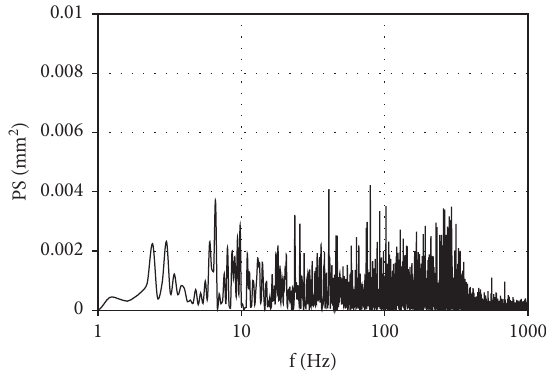
Figure 10: Power spectrum of shock oscillations for microstep at X / C � 0.16.